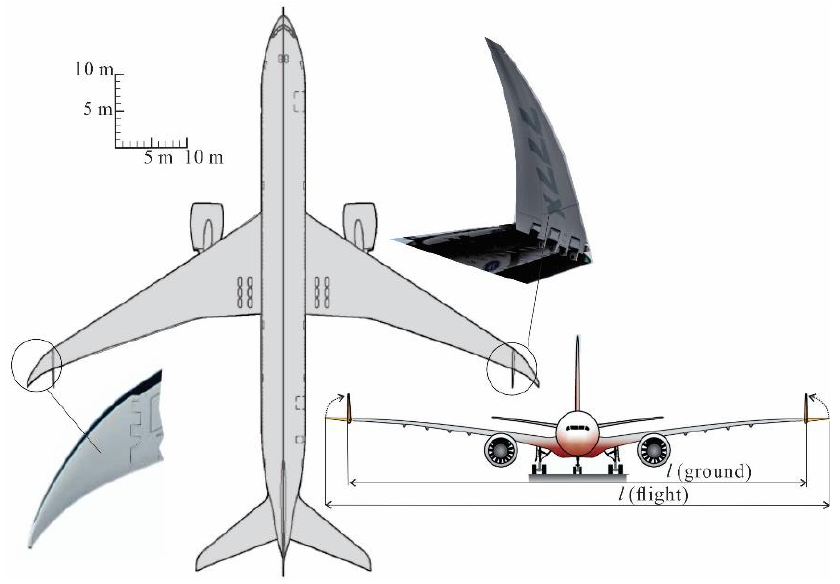
Figure 4. Deflectable wingtips of the Boeing 777X [20,24].